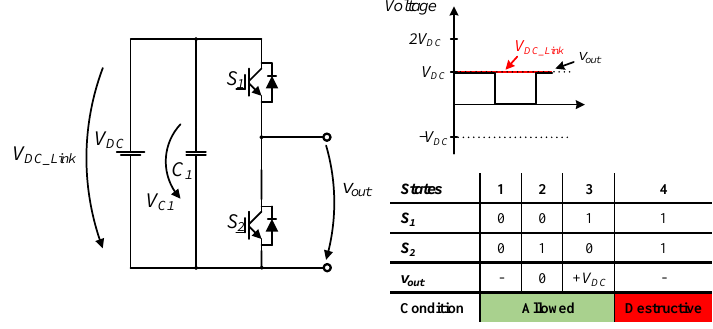
Figure 4. Half-bridge with single DC bus topology and operation principle.